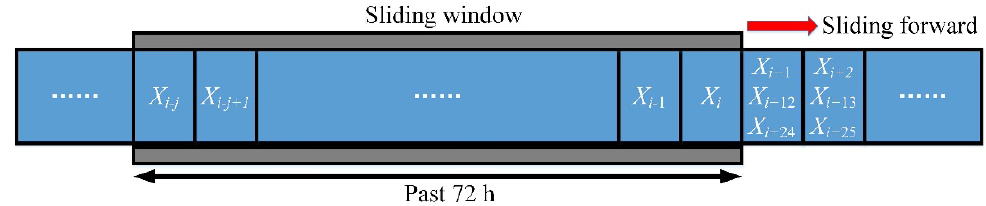
Figure 6. The structure of a traditional sliding window.